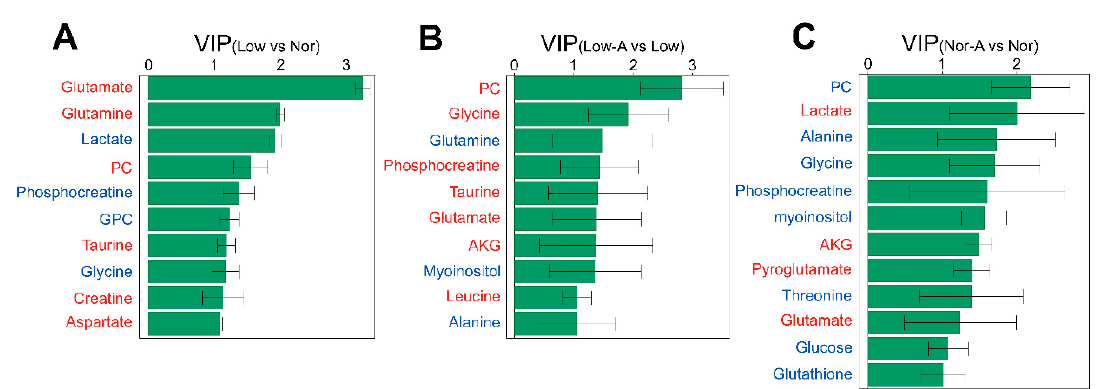
Figure 5. VIP scores of important metabolites identified from pairwise comparisons between the four groups of C2C12 myoblasts. ( A ) Low vs. Nor.; ( B ) Low-A vs. Low; ( C ) Nor-A vs. Nor. Red/Blue font denotes increased/decreased level of the metabolite.